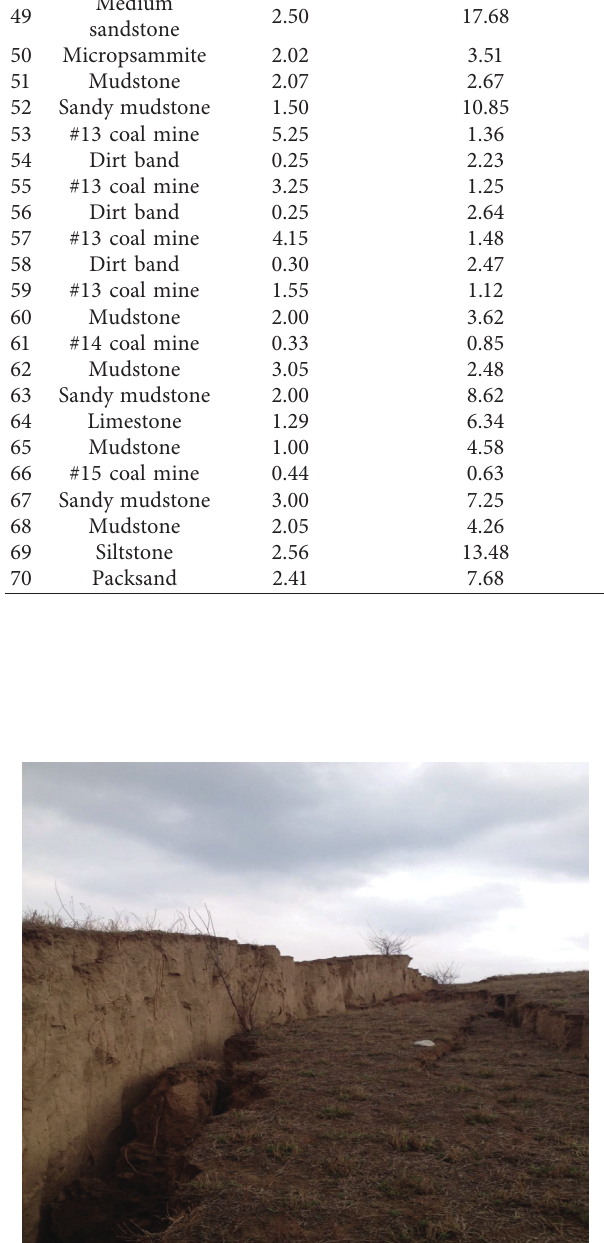
Figure 6: No. 77 support average load during 23103 working face